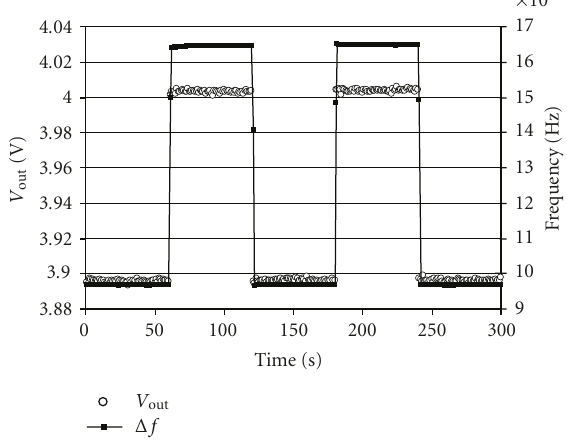
Figure 5: V out from bu ff er stage versus frequency shift for Δ V out = 107 . 6 mV.